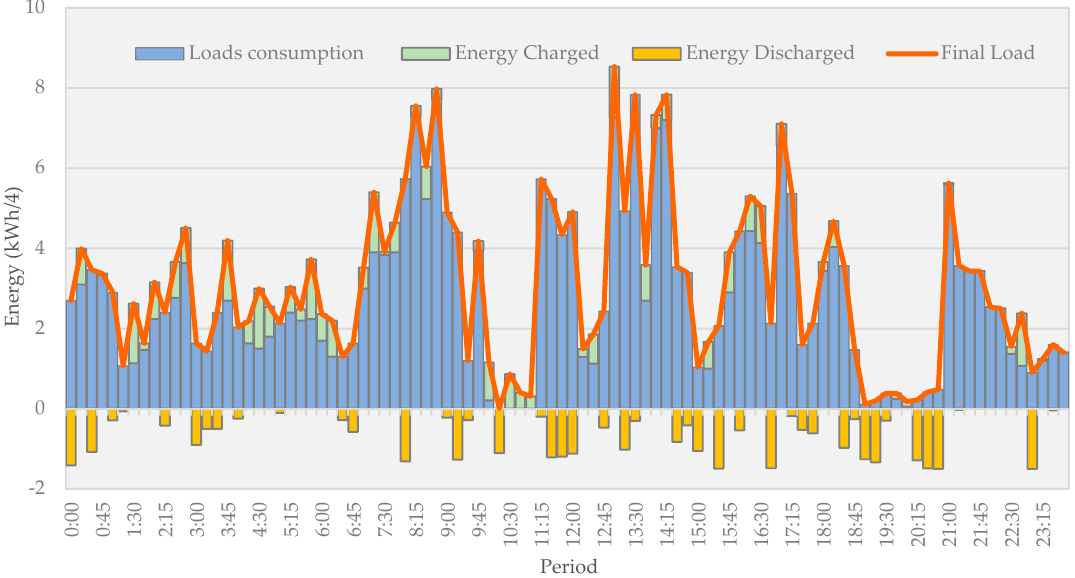
Figure 5. Load consumptions, battery actions, and final load scheduling.